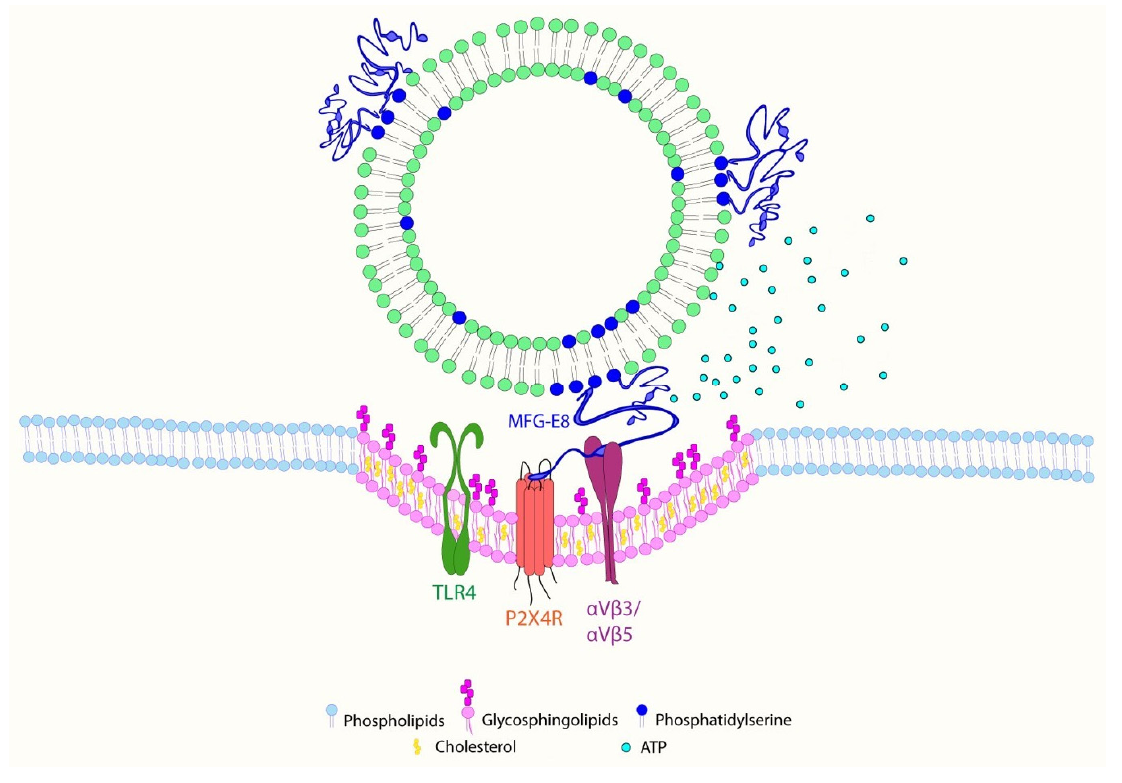
Figure 9. Proposed mechanism for EV action on microglial cells. EVs carrying MFG-E8 proteins associated with phosphatidylserine exposed on the outer membrane are recognized by the α V β 3/ α V β 5 integrin receptors of microglial cells and trigger lipid raft formation, interaction with P2X4 receptors, and possibly other molecules enriched in the lipid rafts such as components of the TLR4 multireceptor complex. These events lead to the upregulation of intracellular Ca 2+ , release of ATP, and increased motility of microglia.